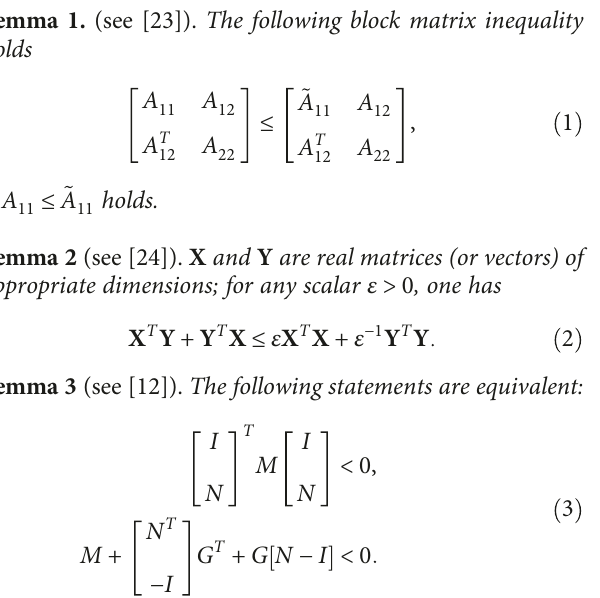
Figure 1: (a) The Morphing aircraft with variable sweep angle and variable span. (b) Depiction of the multibody